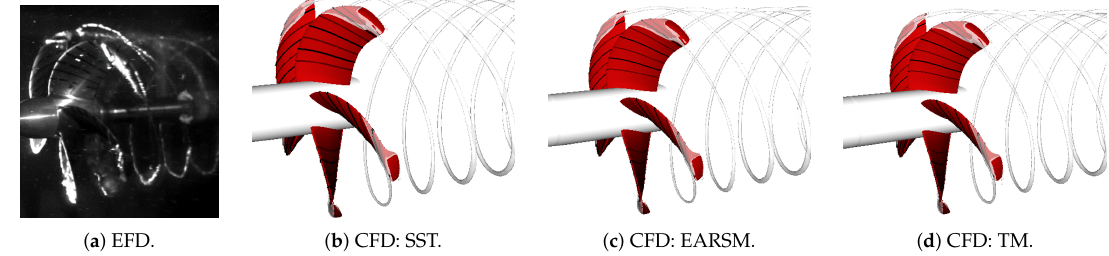
Figure 11. Comparison of model-scale cavitation patterns for the TLP.